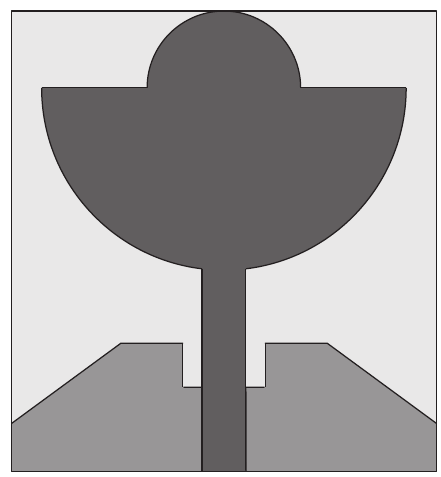
Figure 20: Miniaturized UWB printed monopole antenna with a dome-topped, bowl-shaped patch and truncated ground plane provided with a notch [72]. Dark gray upper metal face, medium gray bottom metal face, and light gray dielectric